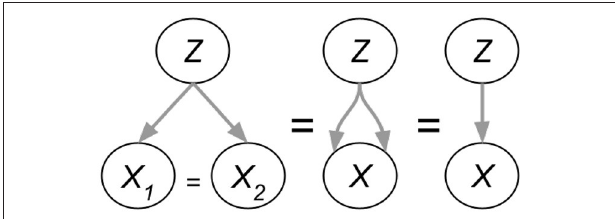
FIGURE 6 | Three-way confounding relations collapsing to a two-way causal relation.